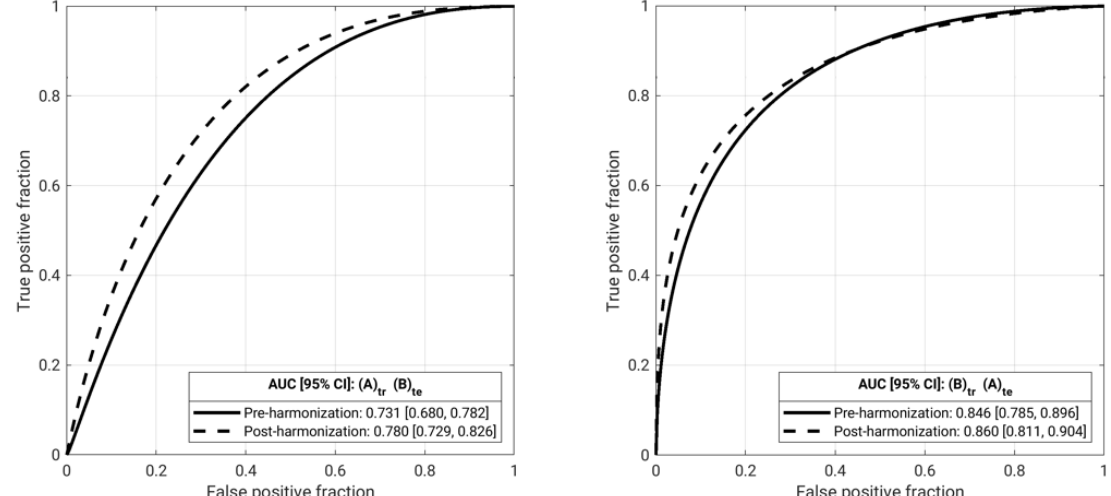
Figure 7. Classification performance results after batch feature harmonization and feature selection harmonization: Receiver operating characteristic (ROC) curves for training and testing between each database in the task of classification of lesions as malignant or benign, using a database-specific independent test set determined by date of image acquisition. Solid lines show the ROC curve when using pre-harmonization features, while dashed lines show the ROC curve when using post-harmonization features. AUC values are given in Table 3 (A: Database A; B: Database B).